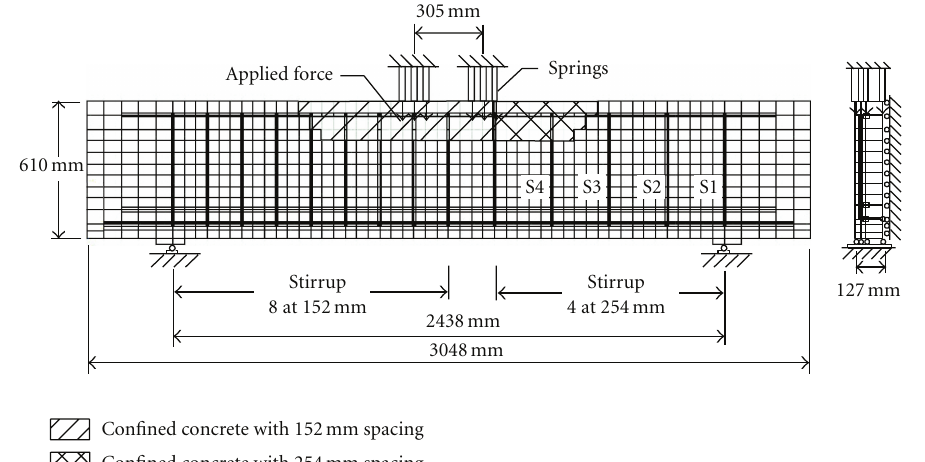
Figure 4: Finite element model for undamaged beam